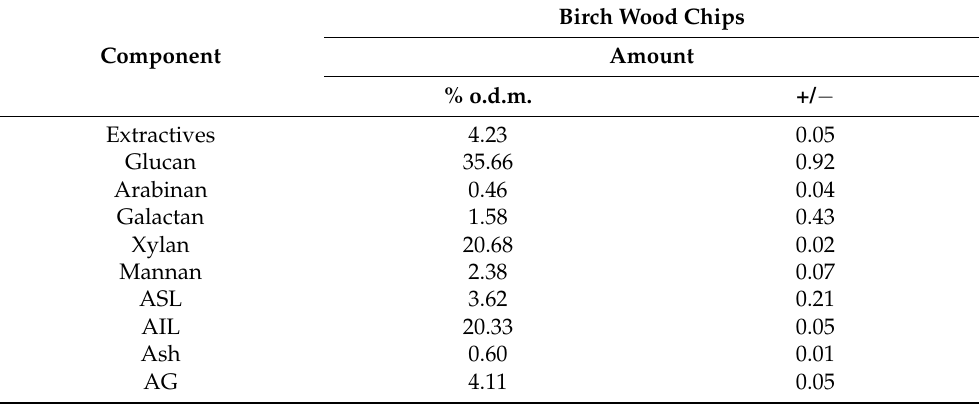
Table 1. Chemical composition of wood chips used.